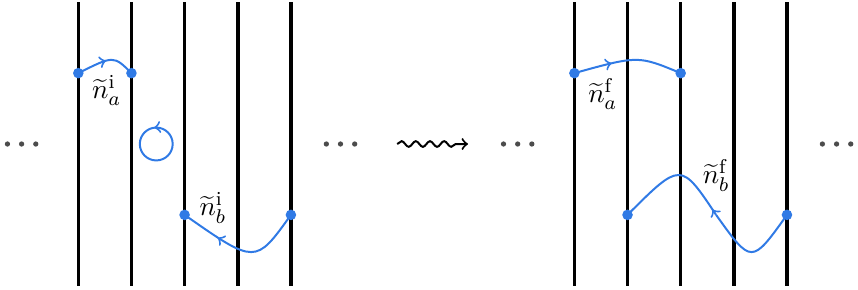
= n 1 and n i = n 2 . The a b = − n 3 and n f = − n 4 . The amplitude a b